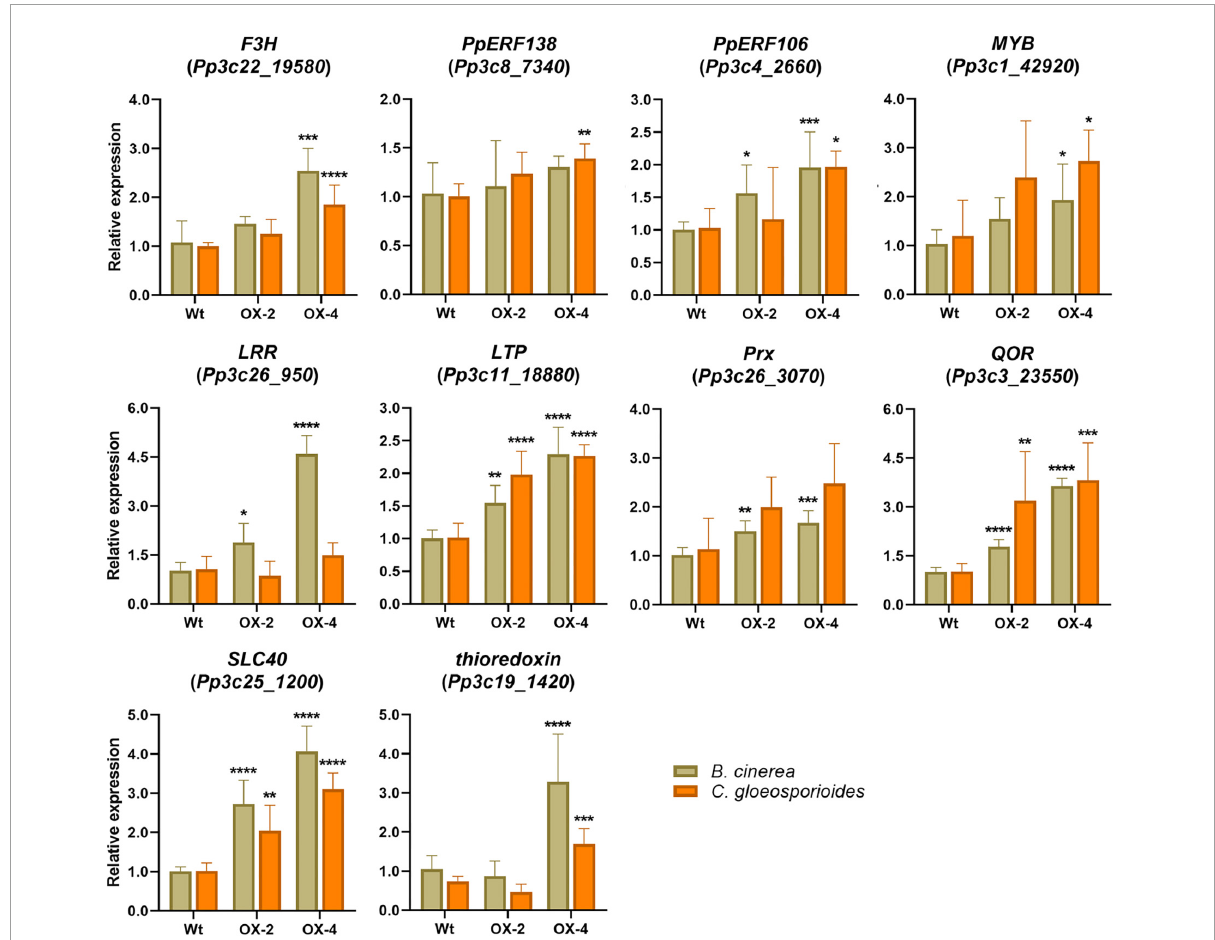
FIGURE7 Expression levels of defense genes in fungal-inoculated wild-type and PpERF24 overexpressing plants. Transcript levels in PpERF24 overexpressing lines inoculated with B. cinerea or C. gloeosporioides at 24 hpi were expressed relative to the corresponding levels in pathogen-inoculated wild-type plants, using Ubi2 as reference gene. Results are reported as means ± standard deviation (SD) of four samples for each treatment. Asterisks indicate a statistically significant difference between wild-type and overexpressing plants (Student’s t -test, * P ≤ 0.05; ** P ≤ 0.01; *** P < 0.001; **** P <